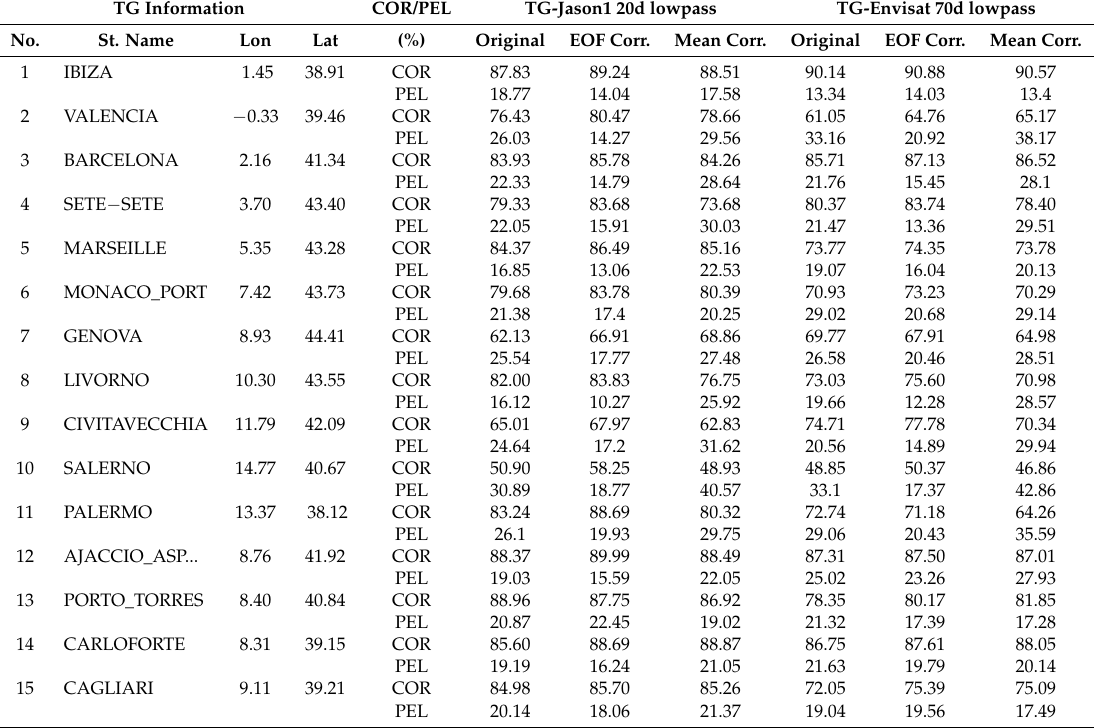
Table 2. The PEL and COR of the difference between the long period (2 T s low-pass) satellite altimeter SLAs and TG at 15 TG sites. The SLA were corrected with the spatial average method (Mean Corr.) or EOF analysis method (EOF Corr.). TG Information COR/PEL TG-Jason1 20d